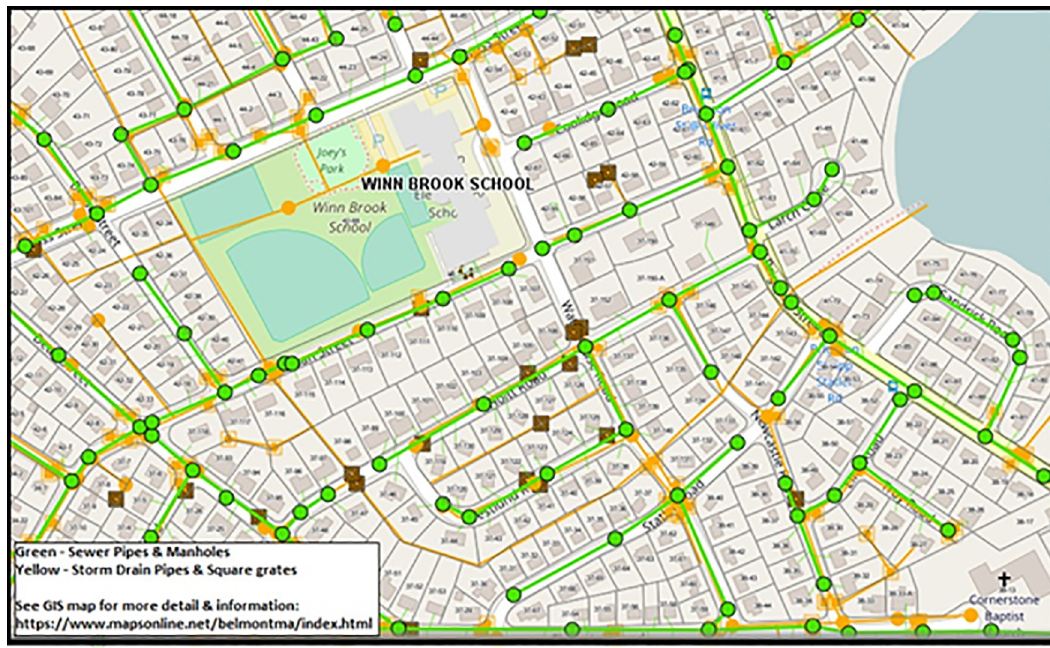
Fig 1. Map of a portion of the underground sewer pipeline network of Belmont, Massachusetts (thanks to PeopleGIS for granting permission to publish this MapsOnline